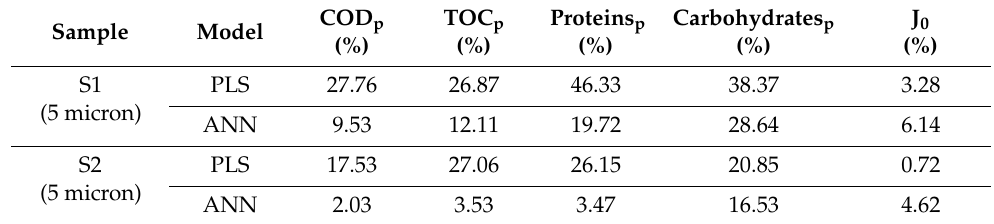
Table 8. The deviation of predicted values from experimental values for both models (PLS and ANN).